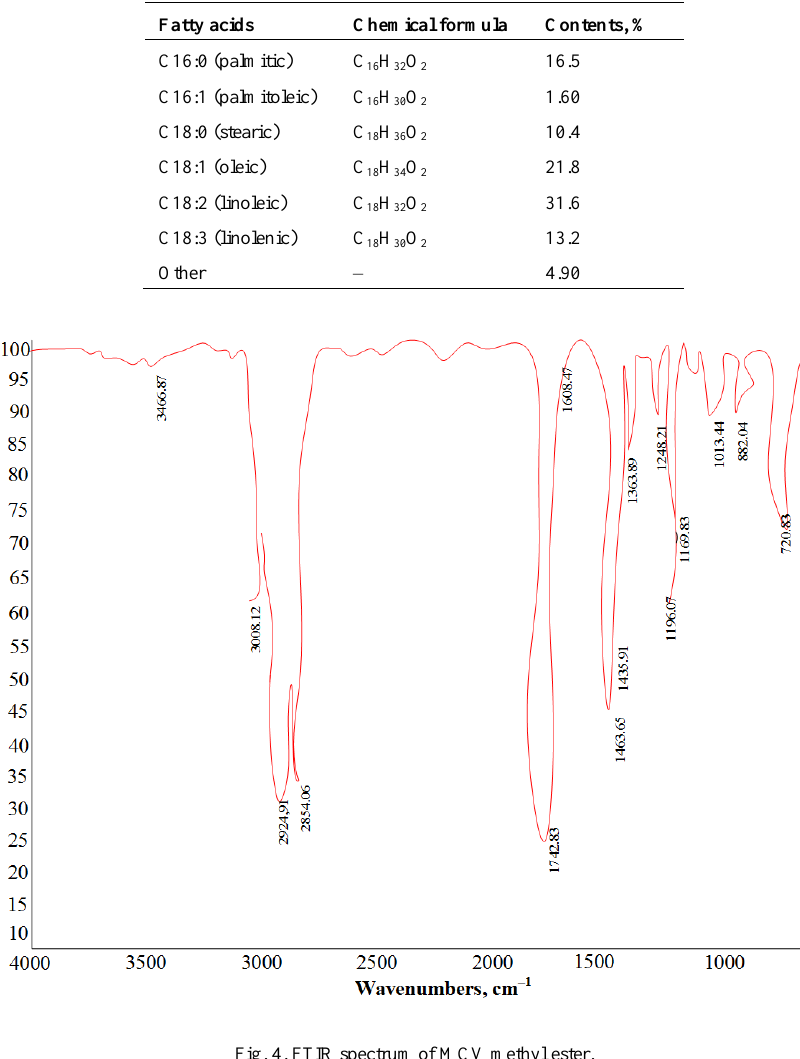
Fig. 4. FTIR spectrum of MCV methyl